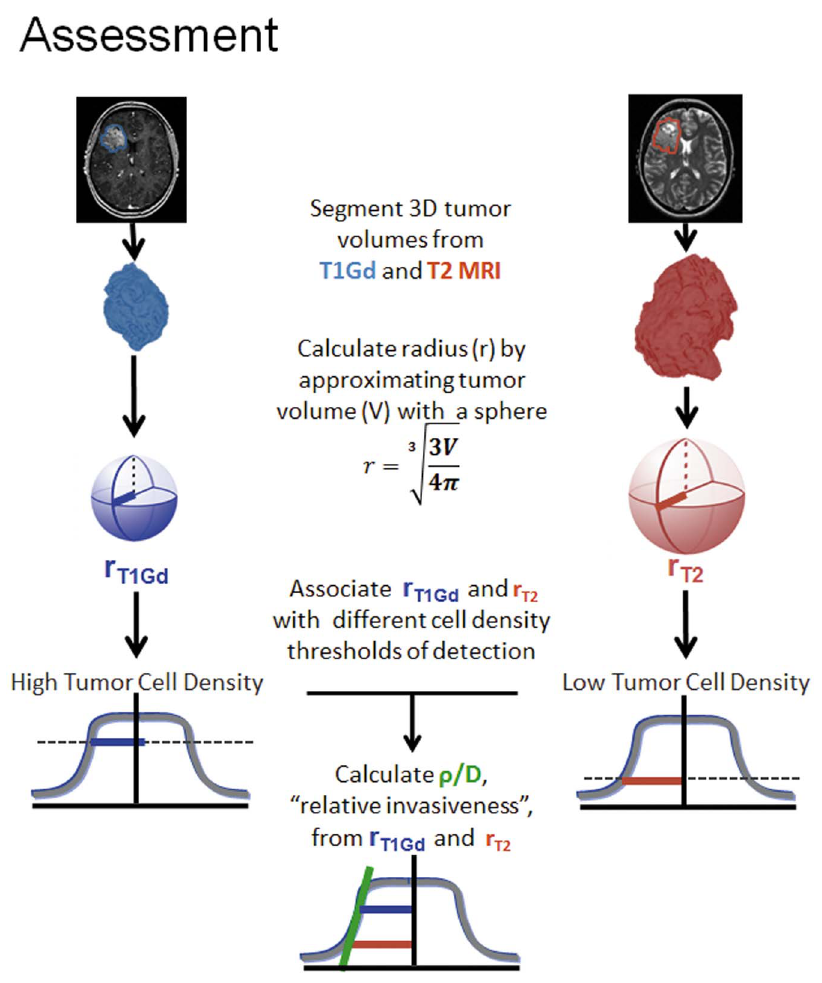
Figure 2. r /D Assessment. This figure presents an overview of how the ‘‘relative invasiveness,’’ or r /D, is obtained. Tumor volumes are segmented from T1Gd and T2 MRI. The measured volume is approximated with a sphere in order to obtain a radius. The T1Gd and T2 radii are associated with different levels of detection, with T2 at low tumor cell density and T1Gd abnormality associated with high tumor cell density. The relationship between these two radii describes the steepness of the tumor cell profile, or ‘‘relative invasiveness.’’